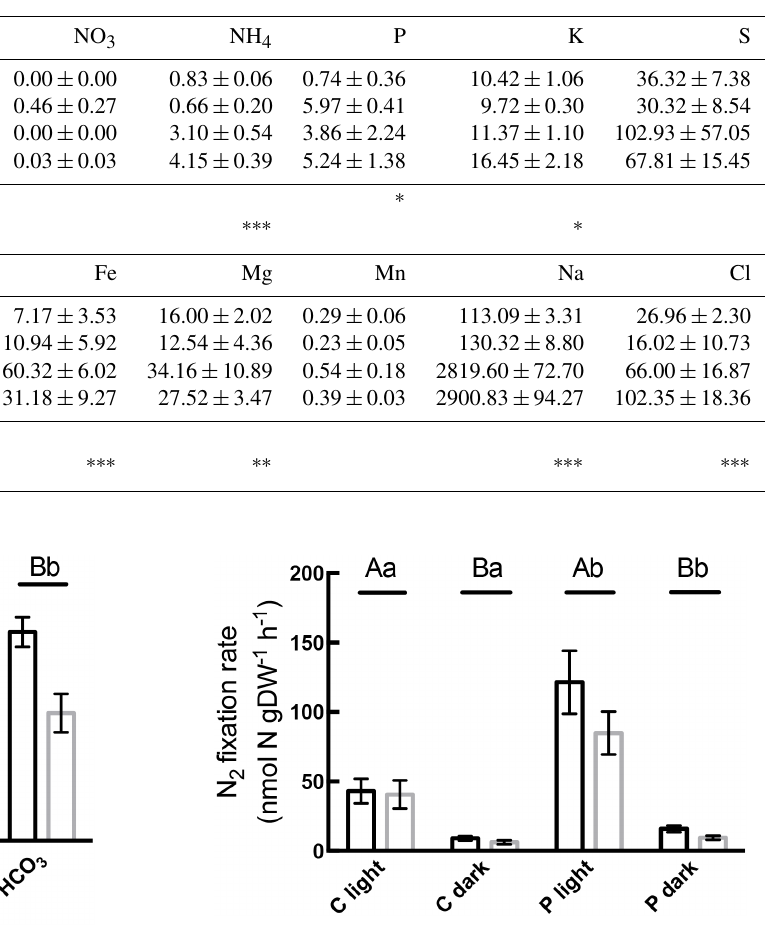
Figure 3. N 2 fixation rates of diazotrophic communities of Sphag- Figure 2. Rates of N 2 fixation of the diazotrophic communities of num squarrosum (dark bars) and S. palustre (grey bars), under light Sphagnum squarrosum (dark bars) and S. palustre (grey bars), un- or dark conditions. Displayed is the mean ± SE (N = 4) of the con- der different treatments. Both P and HCO 3 treatment significantly trol and p treatment (see text). Dark conditions significantly de- increased N 2 fixation in both species, shown by letter combinations: creased N 2 fixation rates (shown by capital letters) and P treatment p treatment (capital letters) and HCO − treatment (lower case). 3 significantly increased rates (shown by lower